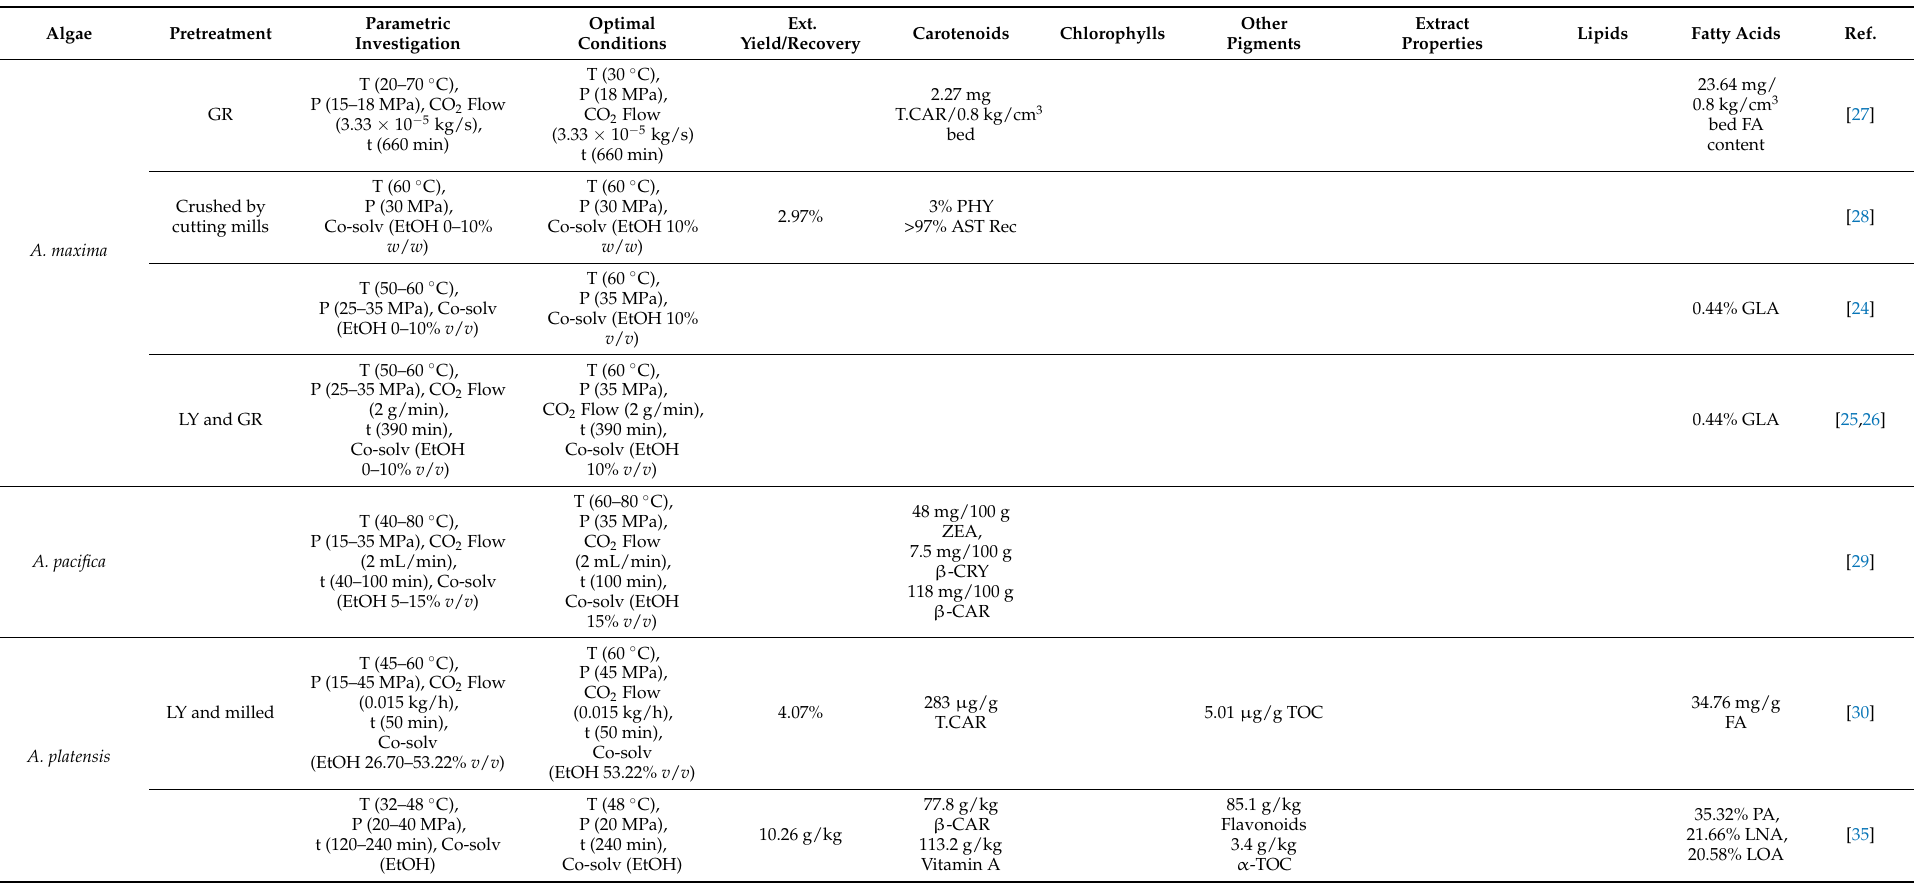
Table 2. SFE conditions applied to microalgae and extracts’ properties and